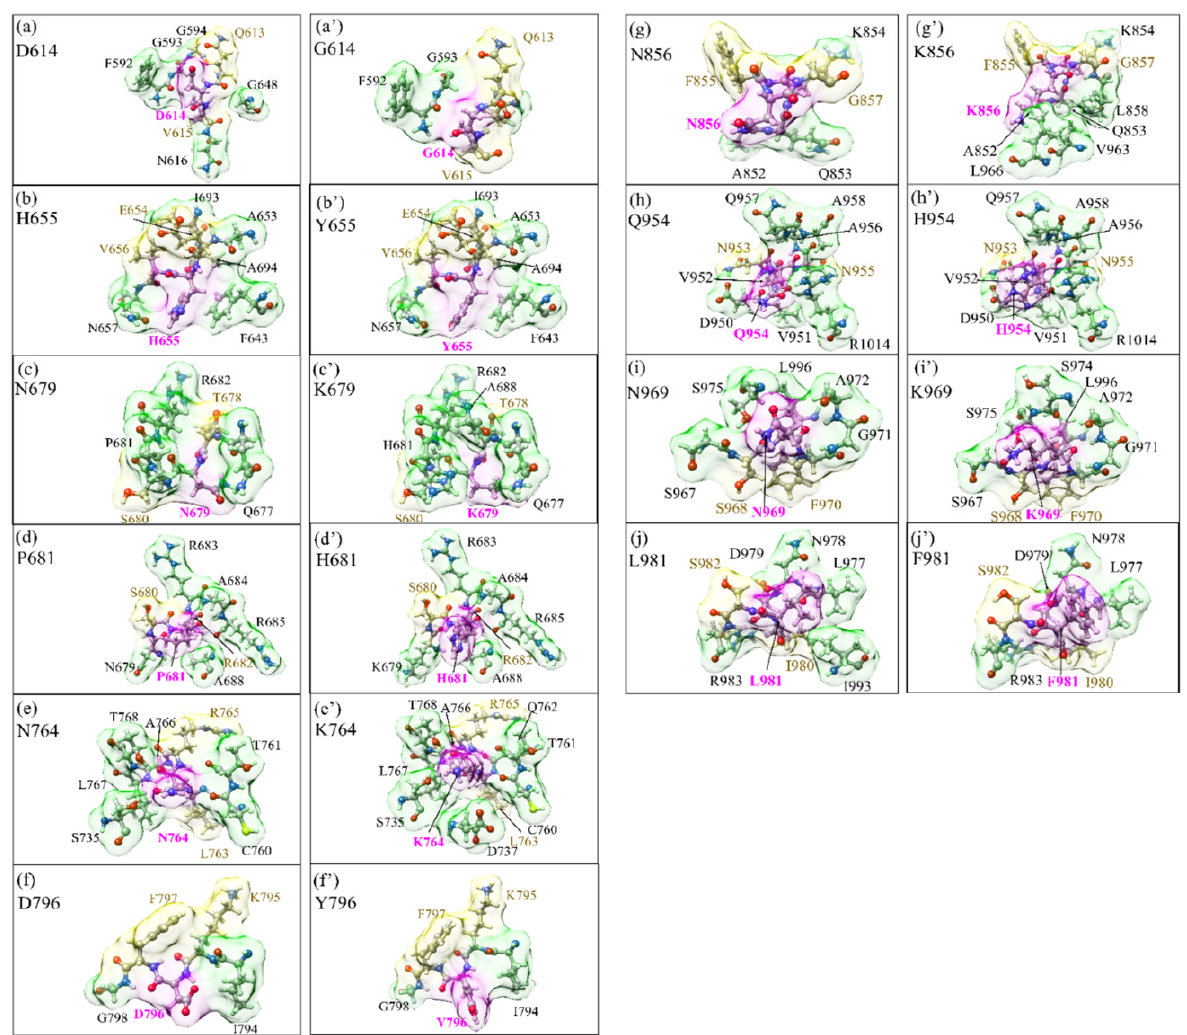
Figure 3. Distribution of the six mutation sites in SD2-FP ( left panel) and four mutation sites in HR1-CH ( right panel). Within each panel, ( a ) to ( j ) on the left column is for the WT, and ( a ′ ) to ( j ′ ) on the right column is for the OV. The surface of mutated sites is shown in magenta, surface of NN and NL are shown in yellow and green, respectively. All NN and NL AAs are marked near to their surface in brown and black, respectively. The geometrical scale is kept the same in all figures.